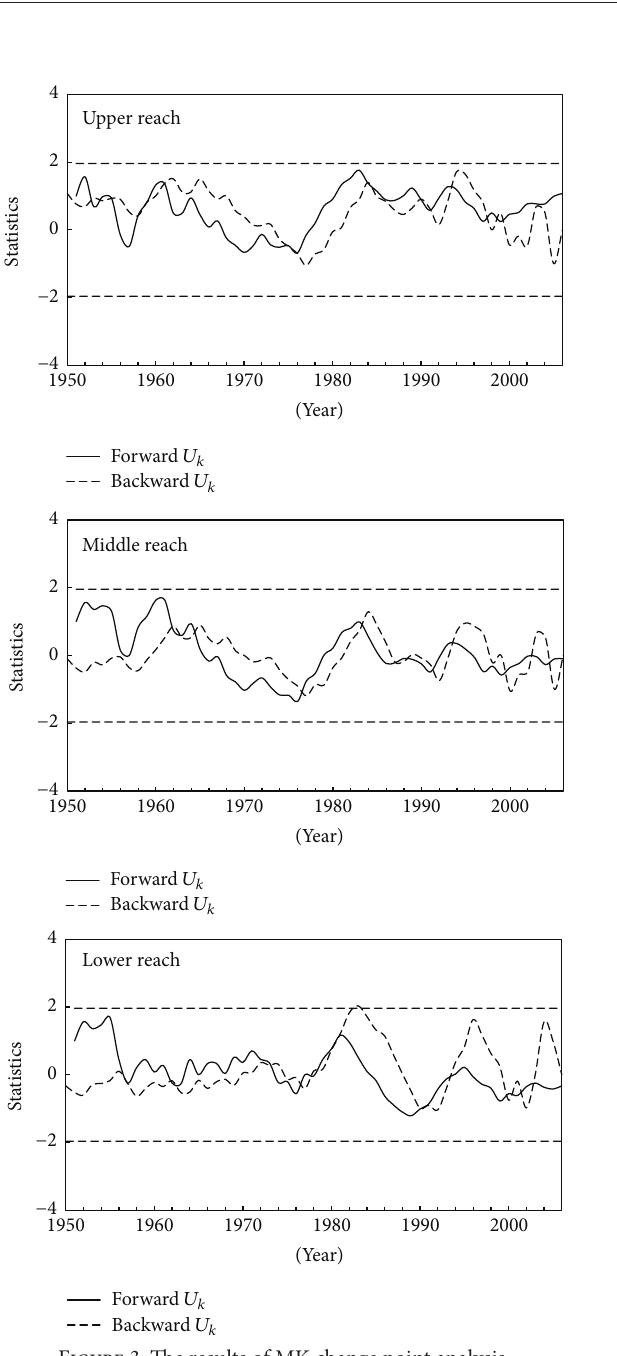
Figure 3: The results of MK change point analysis. around 1976 are obtained for the middle reach precipitation in Figures 3 and 4. For the precipitation in lower reach, the employed for the robustness purpose. The results of the turning point is found in 1981 in both Figures 3 and 4, which Pettitt analysis also show the turning point in 1976, as shown is also not significant at 95% confidence level. The increase in Figure 4. The similar results about the trend changing trend is changed into the decrease trend after this